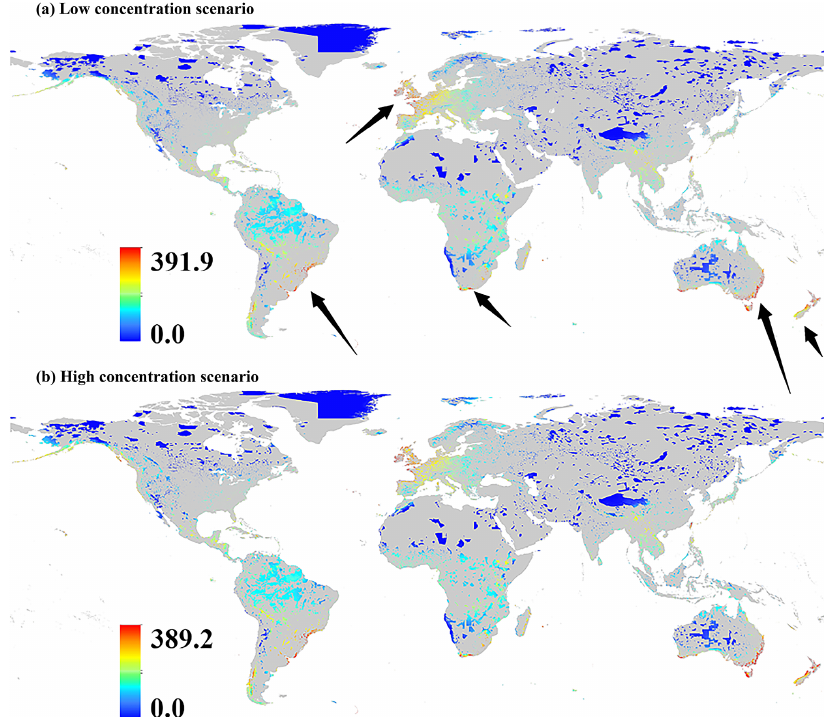
Figure 1. Maps of the global potential pathways of invasive plant species (IPS) in protected areas (PAs) under climate change. (a) Global potential pathways of IPS in a low-gas-concentration scenario; (b) Global potential pathways of IPS in a high-gas-concentration scenario. Black arrows represent the highlighted potential pathways of IPS in PAs under climate change.